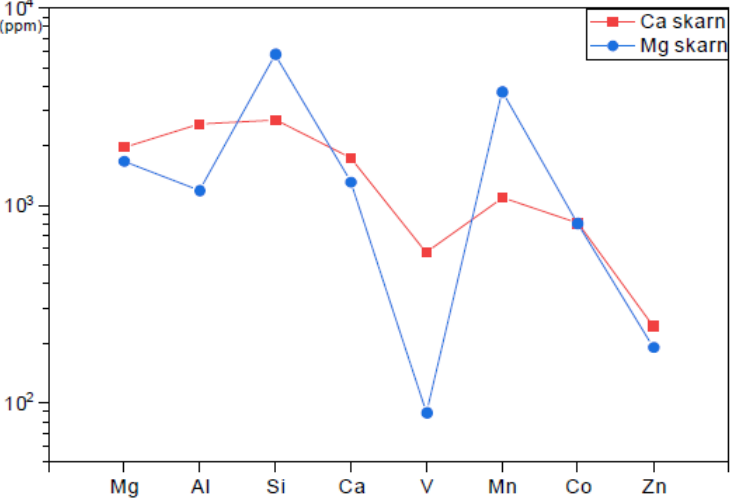
Figure 4. Average EPMA element contents of magnetite from calcic and magnesian skarns.